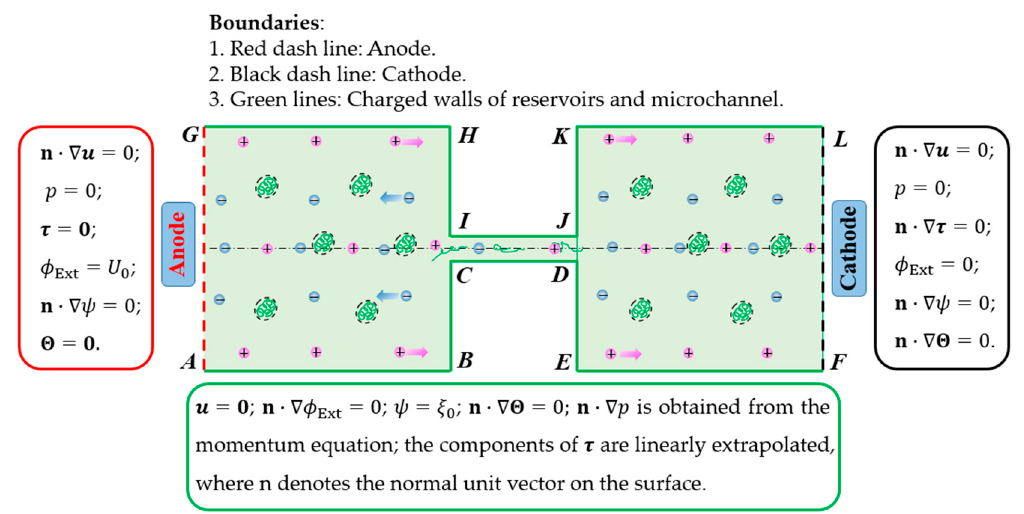
Figure A4. Boundary conditions with n denoting the normal unit vector on the surface.